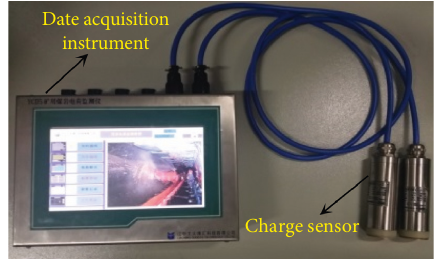
Figure 8: Portable coal and rock charge monitor.